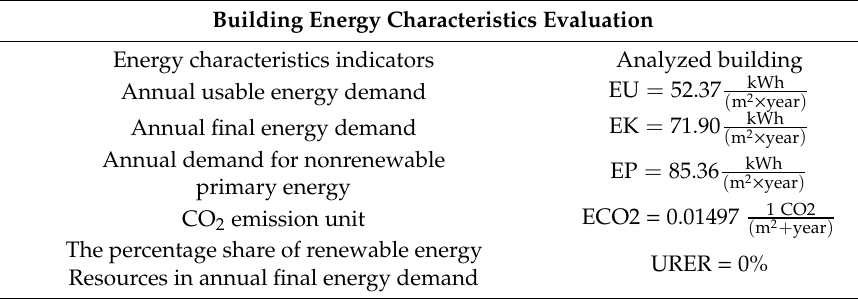
Table 5. Energy consumption and the environmental impact of a traditional building.